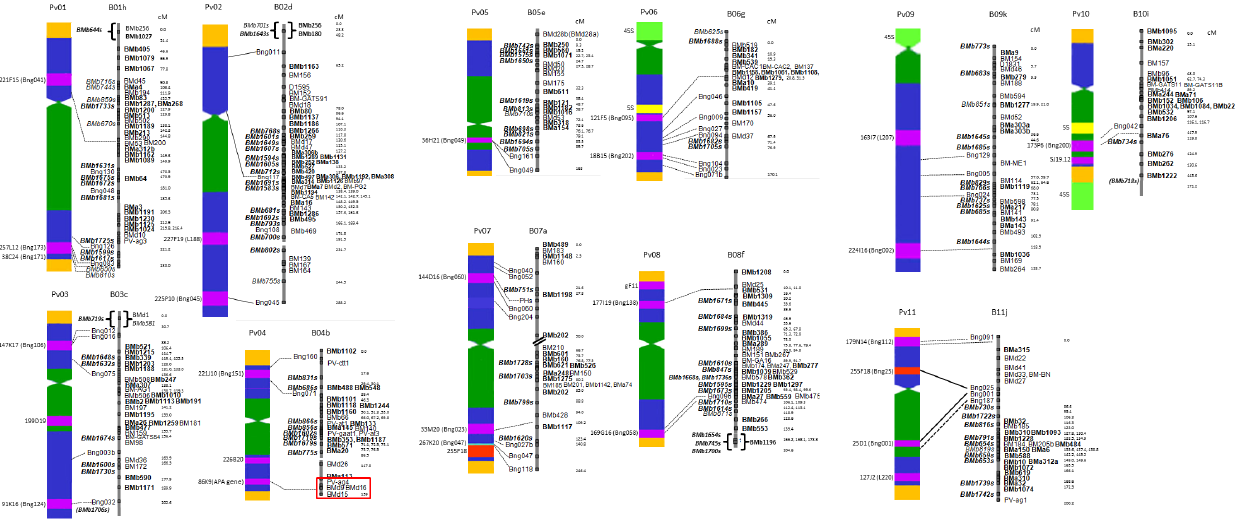
Figure 1. Comparison between common bean genetic and cytogenetic maps. The genetic map for DOR364 6 G19833 is shown on the right with previously mapped contig-based BMb markers on the right side of the bar and singleton-derived BMb(s) markers and Bng markers to the left side of the bar. Non-gene derived BMb markers are in bold while gene-based markers are in normal text. To the left of each linkage group genetic map is the cytogenetic map for the corresponding chromosome from Fonseˆca et al. [26], where subtelomeric region gene-rich BACare in dark orange-red, single copy regions are in purple, peri-centromeric regions are in dark green, interstitial regions are in dark blue, 5S rDNA are in light yellow and 45S rDNA are in light green. The integration points between genetic and cytogenetic maps are indicated with continuous lines (same Bng marker) and dashed lines (linked Bng marker) based on mapping of the same or closely linked (within , 10 cM) markers in Blair et al. [17]. All LGs are drawn to scale as indicated by cM distances. Red box around APA related markers on genetic map according to Blair et al. [55] align with APA containing BAC on cytogenetic map from Fonseˆca et al. [26]. doi:10.1371/journal.pone.0101873.g001 PLOS ONE |